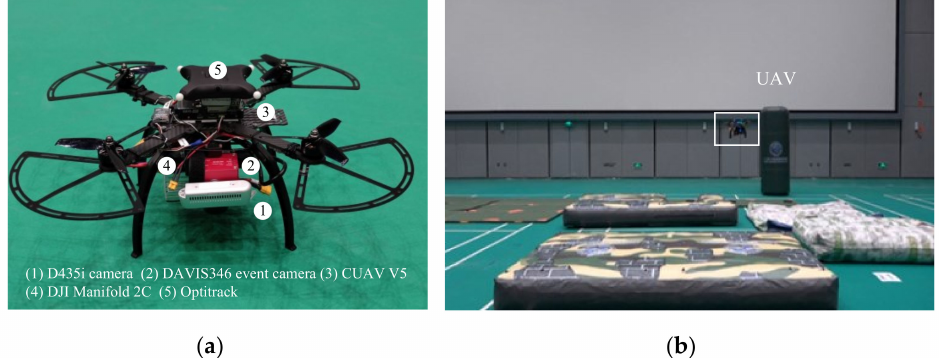
Figure 12. The quadrotor and environment for flight experiments: ( a ) quadrotor platform used for the flight experiments; ( b ) the flying experiment.